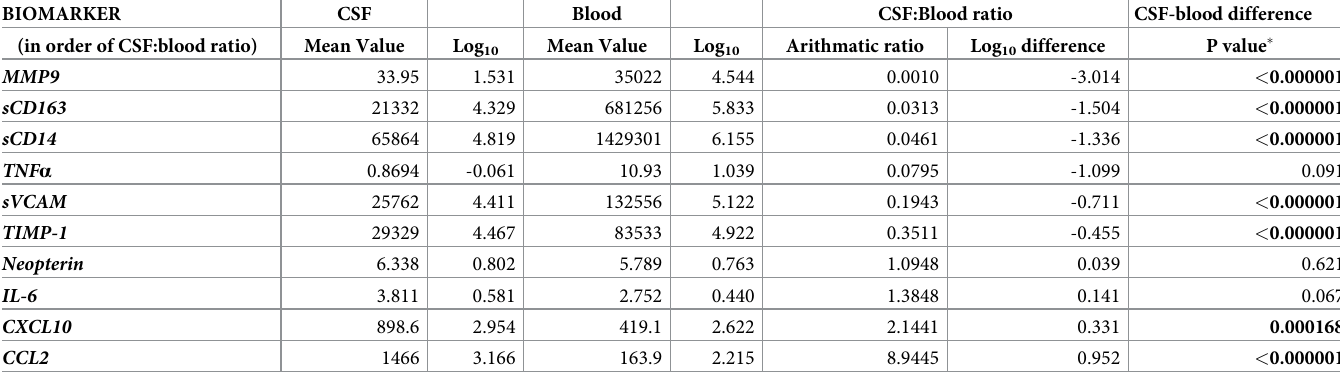
Table 2. Comparison of CSF and blood concentrations of the inflammatory biomarkers in HIV-uninfected group. The ratios between CSF and blood concentrations of the 10 markers are listed in ascending order. BIOMARKER CSF Blood CSF:Blood ratio CSF-blood